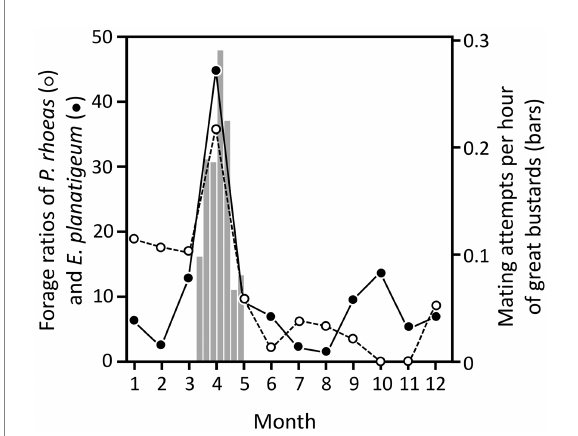
FIGURE 1 Monthly foraging ratios of corn poppy ( P. rhoeas , open circles) and purple viper’s bugloss ( E. plantagineum , filled circles) peaked in April, coinciding with maximum mating activity of great bustards (vertical bars, right axis). Figure composed with plant consumption and availability (Lane et al., 1999), and weekly mating attempts (Magaña, 2007). Vertical bars represent the number of mating attempts per hour, defined as males full-displaying in very close proximity to one or more females (<3 m) with at least one of them showing obvious precopulatory behavior, independently of whether these attempts were followed by effective copulations or not. The number of mating attempts is a reliable indicator of mating success, as indicated by the significant correlation between rates of effective copulations and copulation attempts (Alonso et al., 2010b). The mating attempt rate before and after the period depicted in this figure is